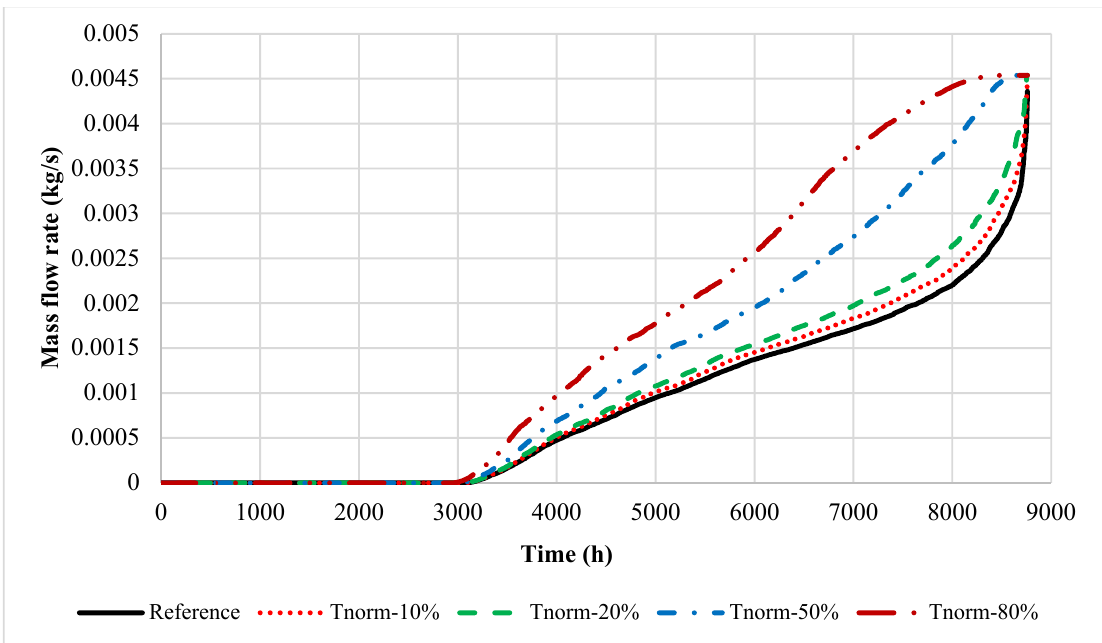
Figure 9. Duration curves of simulated radiator mass flow rate during the year with and without the centralized DR.